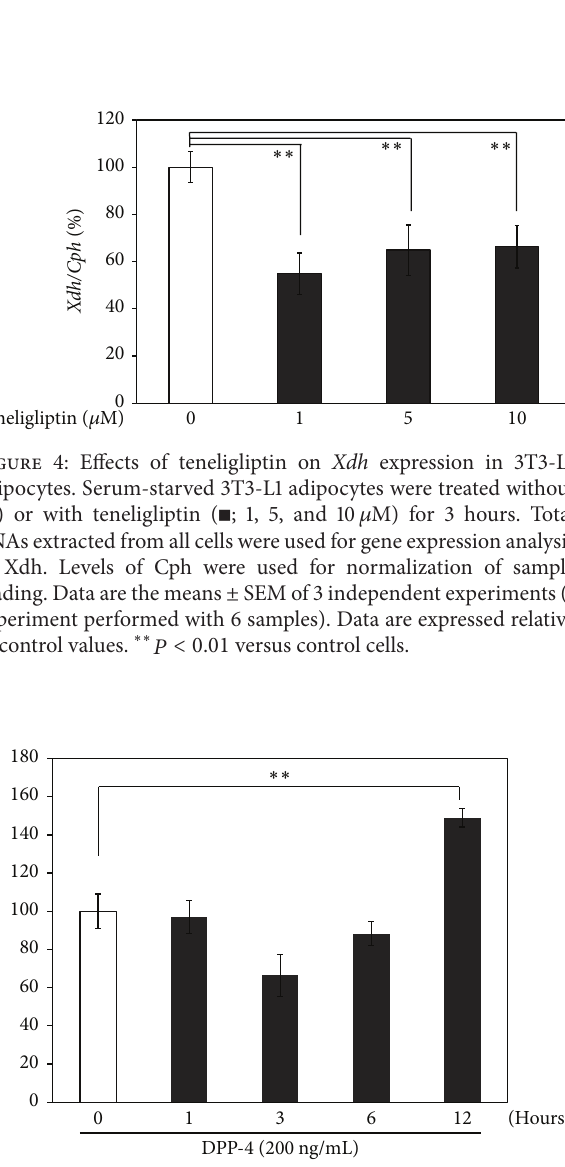
Figure 5: Effects of DPP-4 on Xdh expression in 3T3-L1 adipocytes. Serum-starved 3T3-L1 adipocytes were treated without ( ◻ ) or with DPP-4 ( ◼ ; 200 ng/mL) for the indicated periods (1, 3, 6, and 12 hours). Total RNAs extracted from all cells were used for gene expression analysis of Xdh. Levels of Cph were used for normaliza- tion of sample loading. Data are the means ± SEM of 3 independent experiments (1 experiment performed with 6 samples). Data are expressed relative to control values. ∗∗ 𝑃 < 0.01 versus control cells.